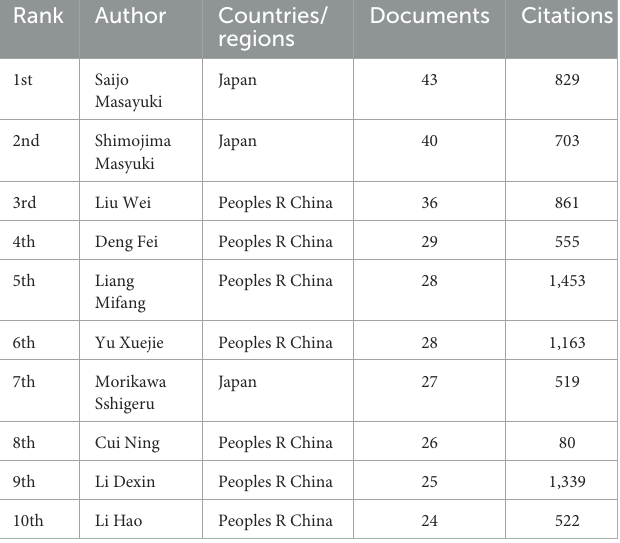
TABLE 4 The top 10 authors in number of publications concerning